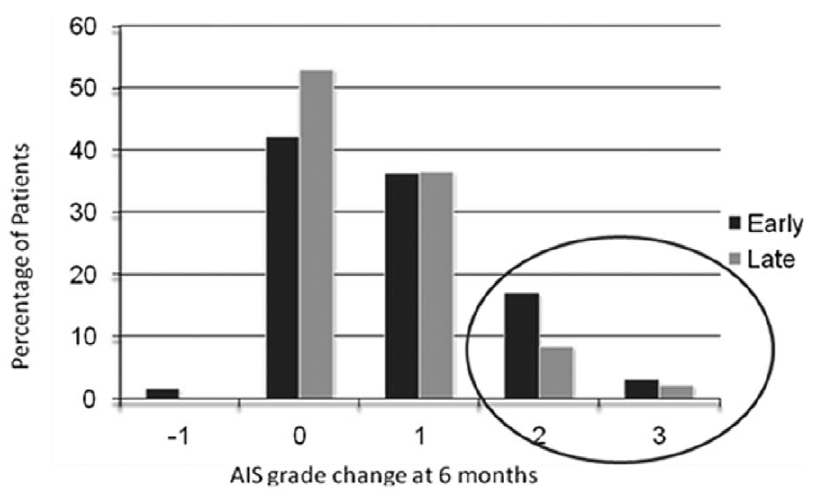
Figure 2. AIS Grade Improvement at 6 months: Early vs. Late Surgery.